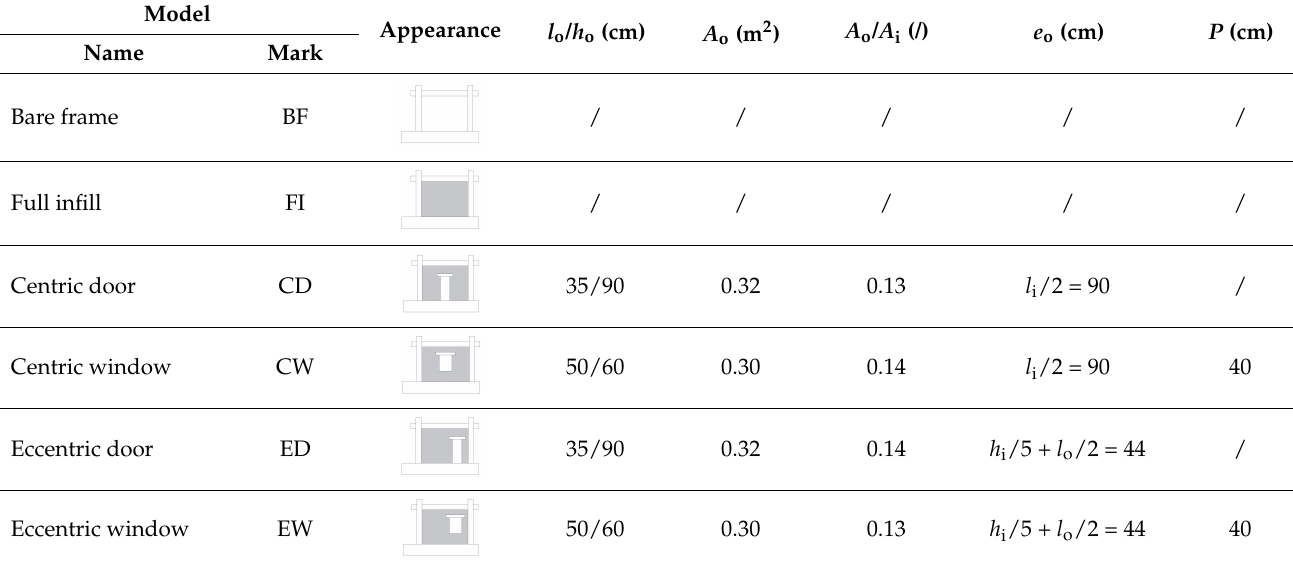
Table 1. Geometrical characteristics of tested